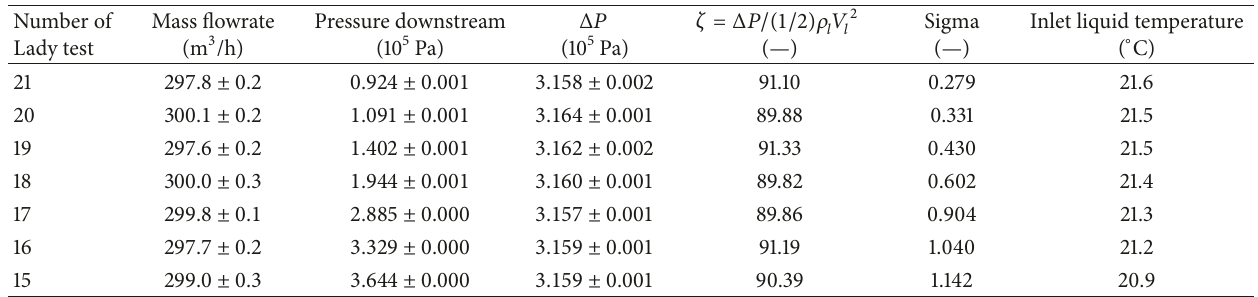
Table 11: Experimental conditions of the EPOCA tests.